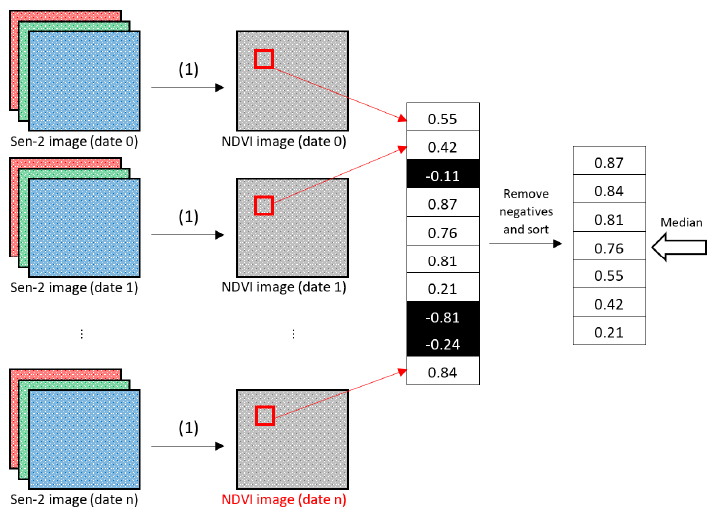
Figure 2. Process of taking topographically flattened Sentinel-2 rasters, applying equation (1) to individual pixels (example shown in red) to obtain NDVI, and discarding negative NDVI values (black cells) for median calculation. Repeat this process for each pixel of a national raster.